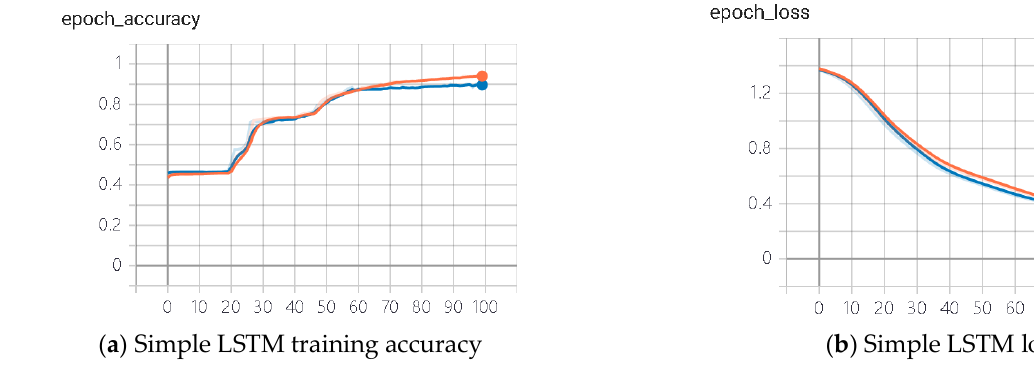
Figure 13. Simple LSTM training parameters diagram.